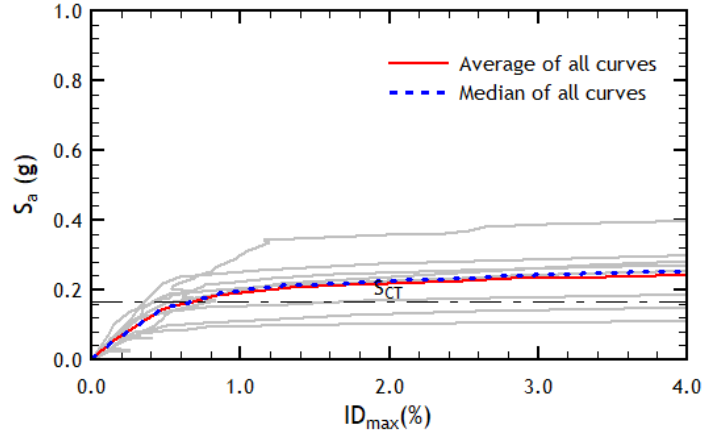
Figure 13. IDA curves obtained by applying the set of accelerograms.